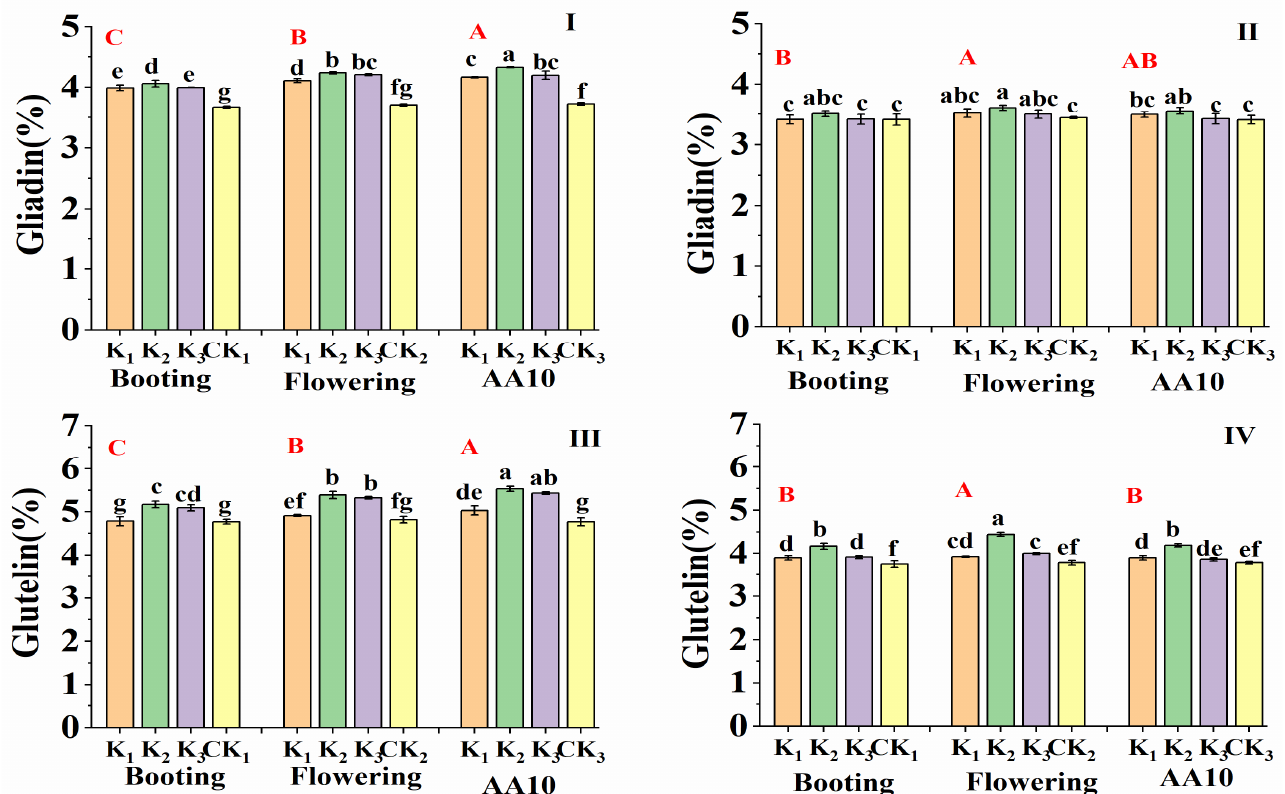
Figure 6. Effects of potassium foliar application on the Gliadin and Glutelin of wheat with Xinong 20 and Xiaoyan 22. Ⅰ and Ⅲ represented Xinong 20, and Ⅱ and Ⅳ represented Xiaoyan 22. Booting (BBCH 48), Anthesis (BBCH 65), and AA10 (BBCH 71): Potassium fertilizer foliar sprayed at booting stage, anthesis stages, and 10 days post anthesis, respectively. K 1 , K 2 , and K 3 represented the application concentration of potassium 30, 60, and 90 mmol L − 1 , respectively. CK: Same amount of deionized water was sprayed on the leaves. Vertical bars represent the mean values ± standard deviation (n = 3). Different lower-case letters indicate a significant difference ( p < 0.05). Different capital letters indicate a significant difference ( p < 0.05) among different spraying stages.